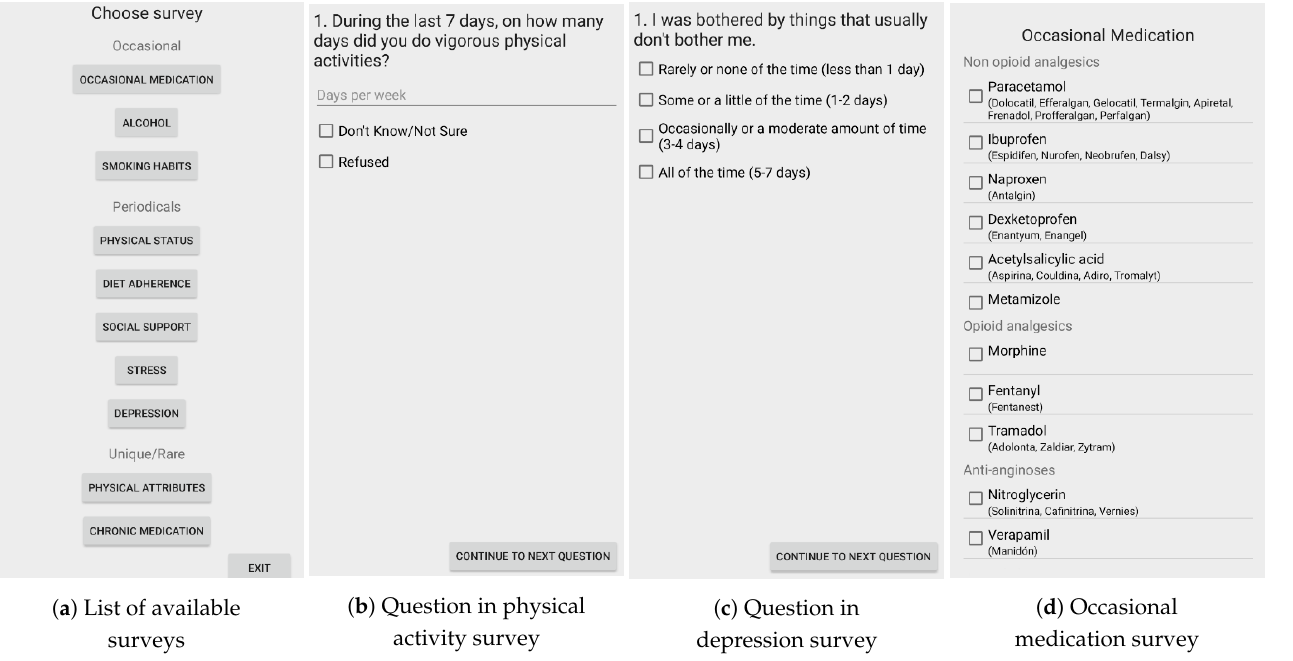
Figure 6. Examples of the user interface related to